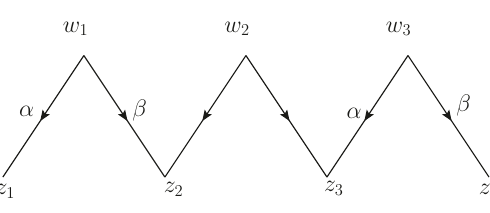
Figure 1 . Diagrammatic representation of the layer operator (cid:3) N =4 ( x ) for a closed spin chain. they are orthogonal to each other with respect to the scalar product (2.18) for di(cid:11)erent sets, ~x = = ~x 0